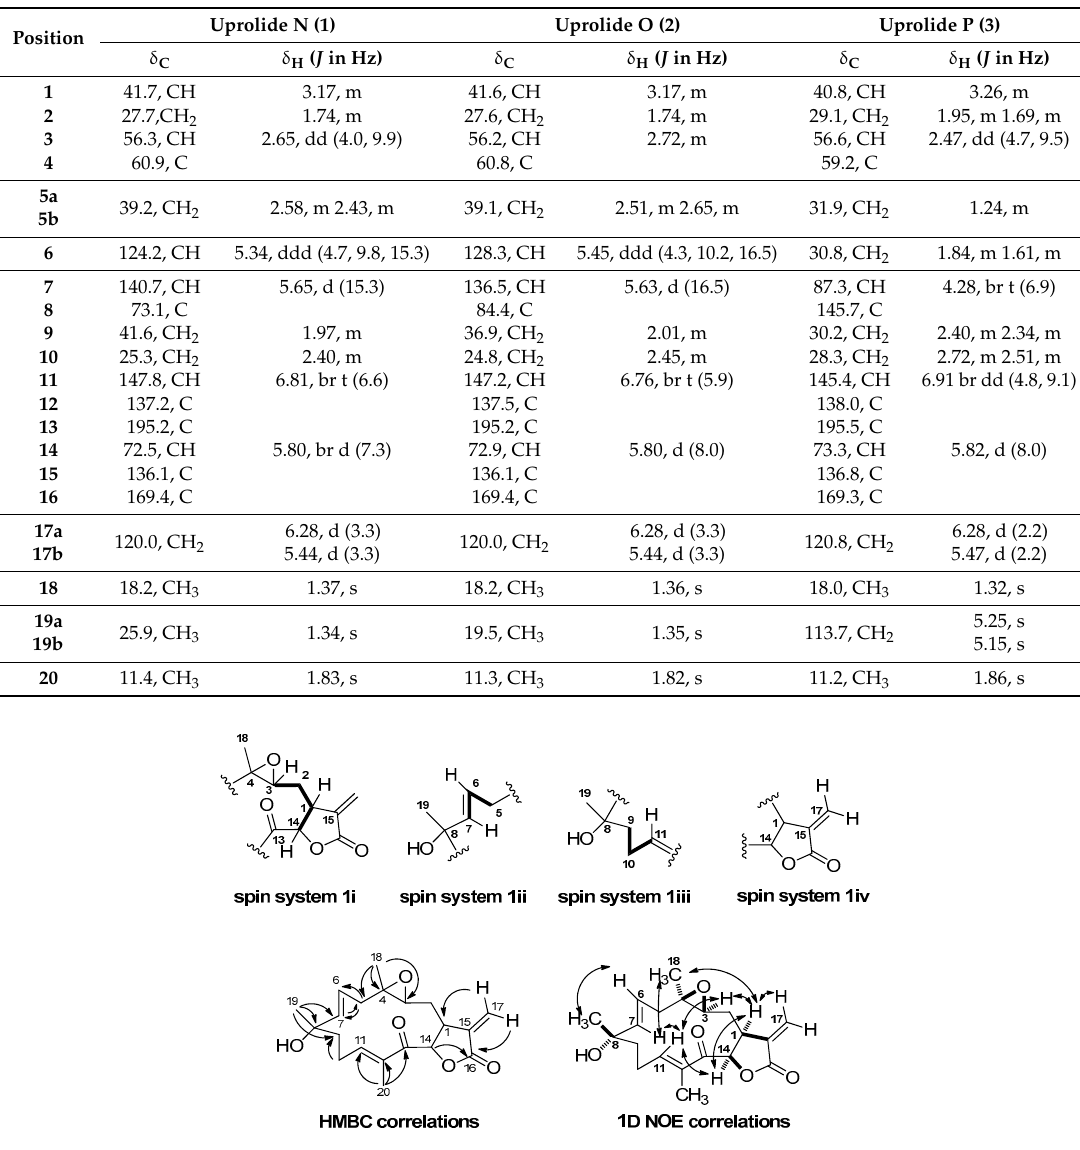
Table 1. 1 H- and 13 C-NMR data in ppm for uprolides N, O and P ( 1 – 3 ) measured in CDCl 3 at 400 MHz.